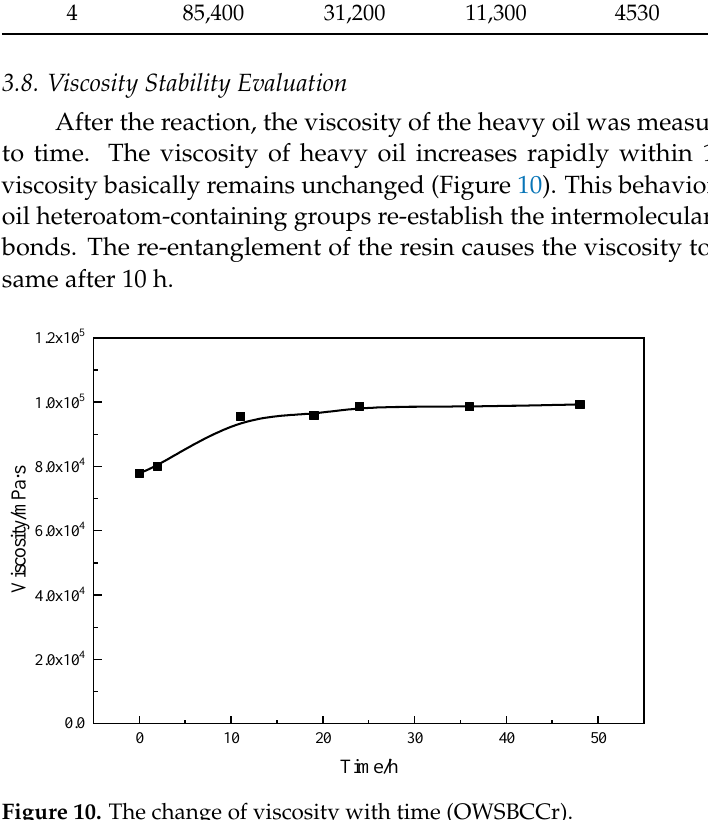
Figure 10. The change of viscosity with time (OWSBCCr).